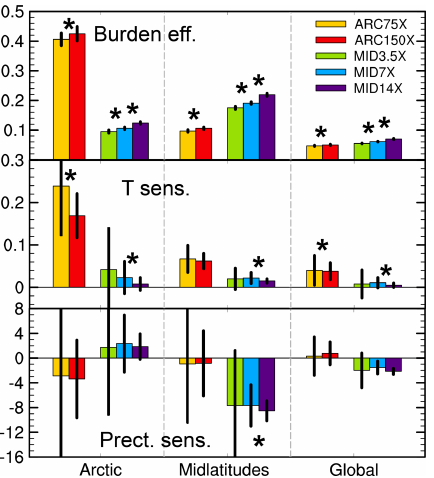
Figure 8. Burden efficiencies, temperature, and precipitation sen- sitivities over the Arctic, midlatitudes, and the whole globe for ARC75X, ARC150X, MID3.5X, MID7X, and MID14X. Burden efficiencies, temperature sensitivity, and precipitation sensitivity are calculated as changes in regional mean BC column burden, sur- face temperature, and total precipitation rate divided by changes in global total BC emissions between perturbed and PD simulations, respectively. Error bars represent 1 σ for 80 annual means. The as- terisks between two bars (ARC75X/ARC150X, MID3.5X/MID7X, and MID7X/MID14X) indicate statistically significant changes with 95% confidence from a two-tailed Student’s t